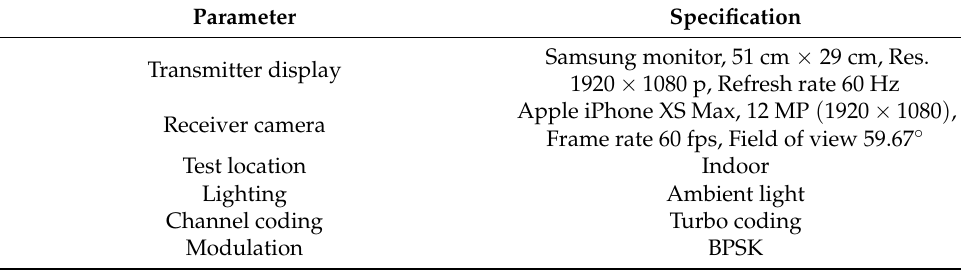
Table 1. Default experimental parameters.